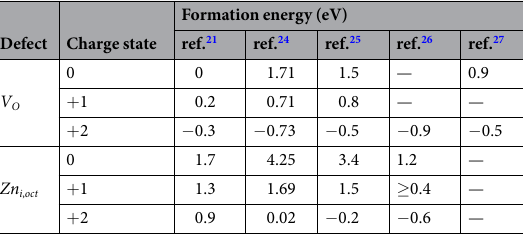
Table 6. Calculated formation enthalpies for V O and Zn i , oct defects in bulk zinc oxide for zinc-rich and p -type conducting conditions [E F = 0 eV,